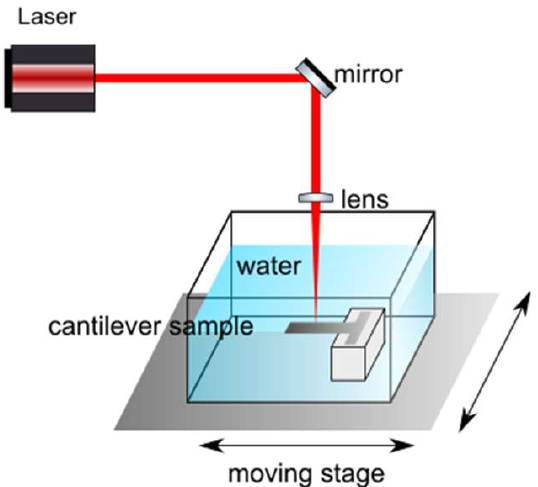
3 of 12 Figure 1. Experimental setup and laser scanning. A moving stage moves the container in the X and Y directions, so the focused Gaussian beam works on the cantilever section of the sample, which is